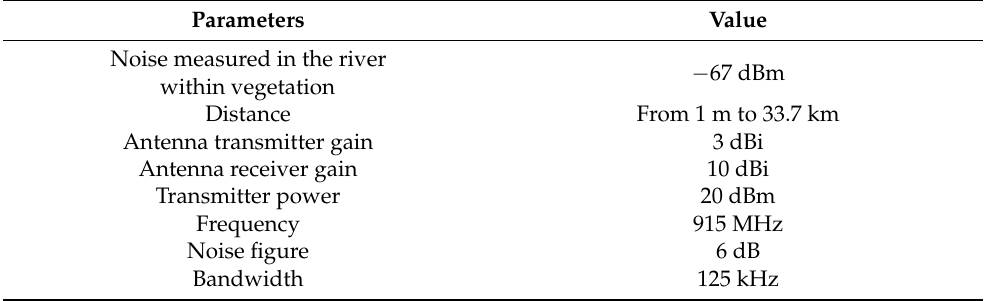
Table 8. Parameters to evaluate the link budget of the experimental and theoretical path loss